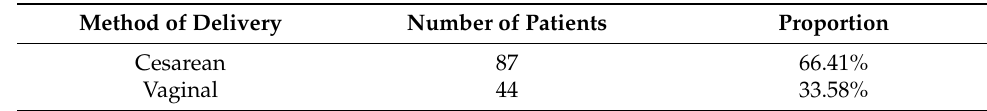
Table 3. The PUUS values of patients regarding the method of delivery ( P = .002).